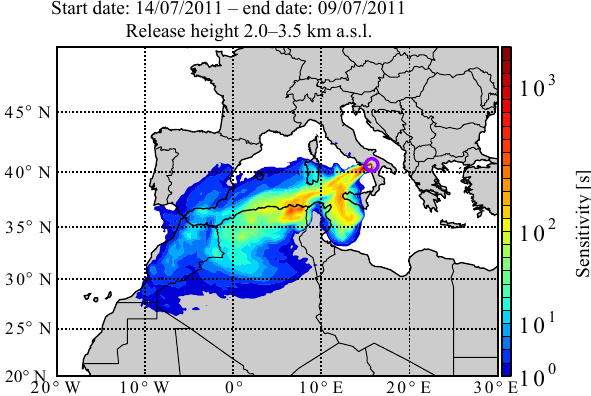
Figure 3. FLEXPART footprint for the air mass traveling below 2km height and arriving at Potenza between 2.0 and 3.5km at 22:00UTC on 14 July 2011. The colors are coded with respect to the logarithm of the integrated residence time in a grid box in sec- onds for a 5-day integration